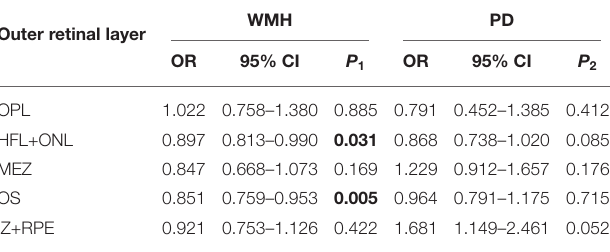
TABLE 3 | Results of multivariate logistic regression for demographic